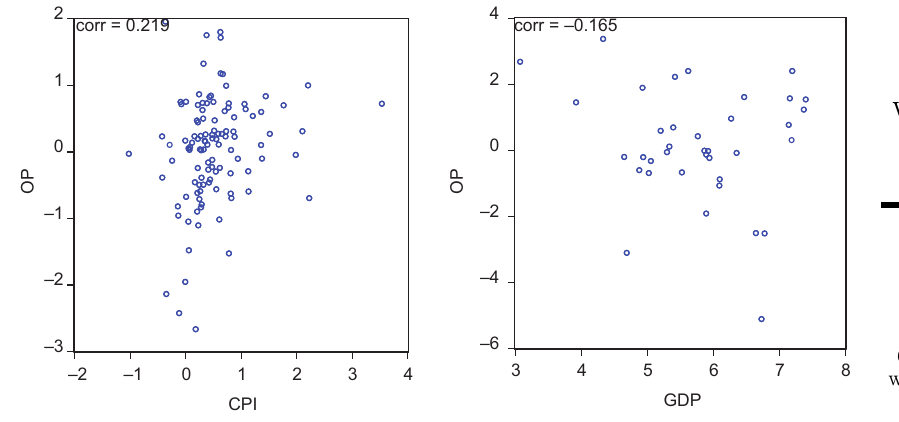
Figure 5. Correlations between